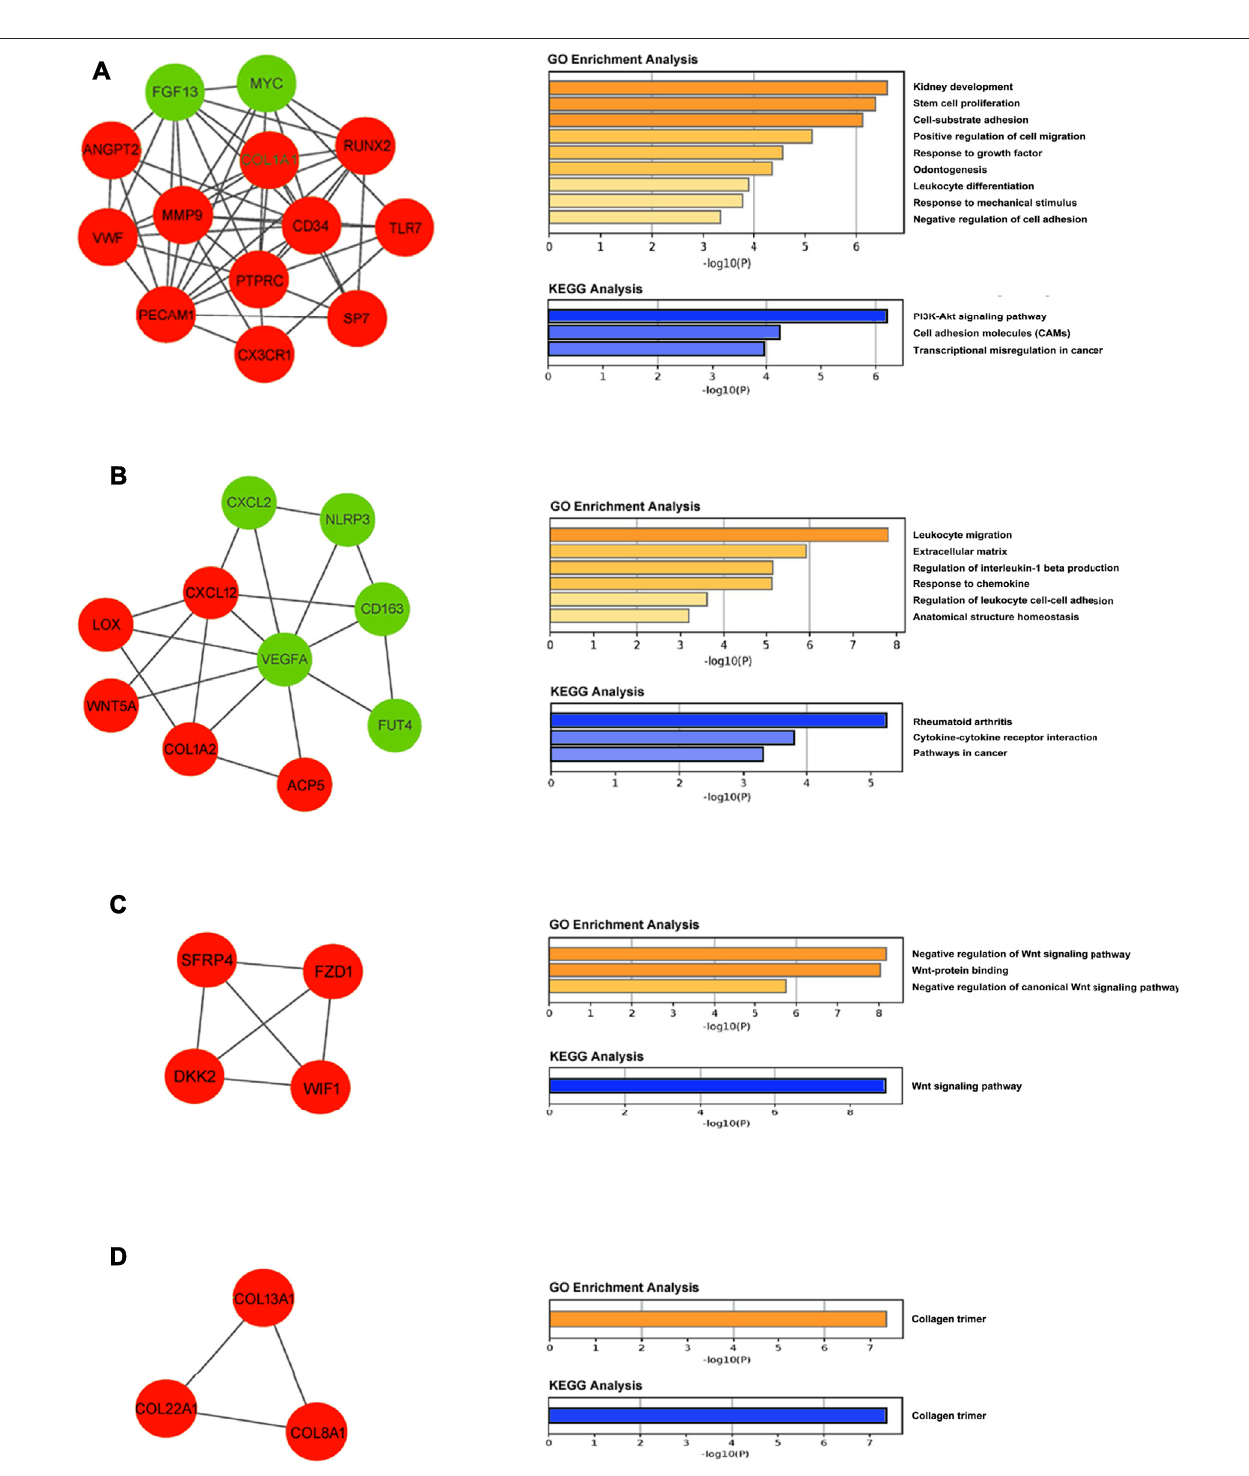
FIGURE 4 | Module analysis. (A) Module one is comprised of 13 genes and enriched in PI3K-Akt signaling pathway and cell adhesion molecules (CAMs). (B) Moduletwoiscomprisedof10genesandenrichedinrheumatoidarthritispathwayandcytokine-cytokinereceptorinteractionpathway. (C) Modulethreeiscomprisedof four genes and enriched in the Wnt signaling pathway. (D) Module fi ve is comprised of three genes and enriched in collagen trimer pathway. Upregulated and downregulated genes are stained with red and green, respectively.